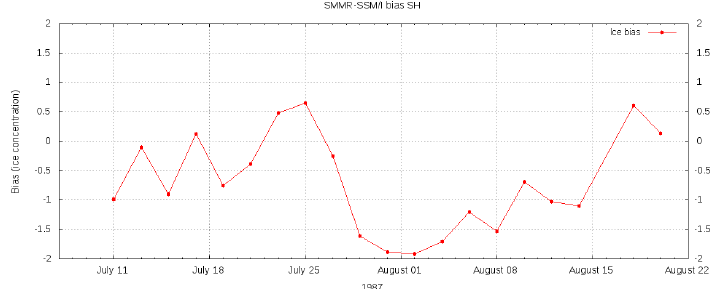
Figure 9. The overlapping SMMR–SSM/I difference around Antarctica during austral winter. The red curve shows the ice bias.